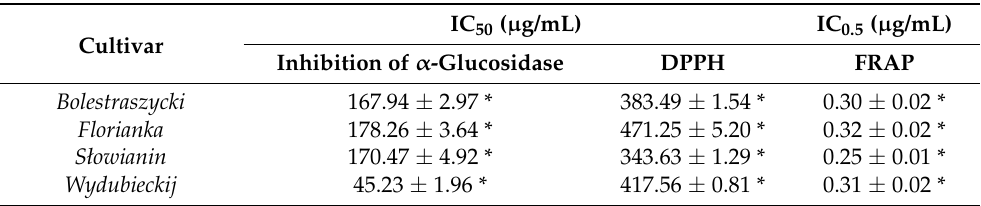
Table 2. In vitro activity of the lyophilized Cornus mas fruit water extracts.